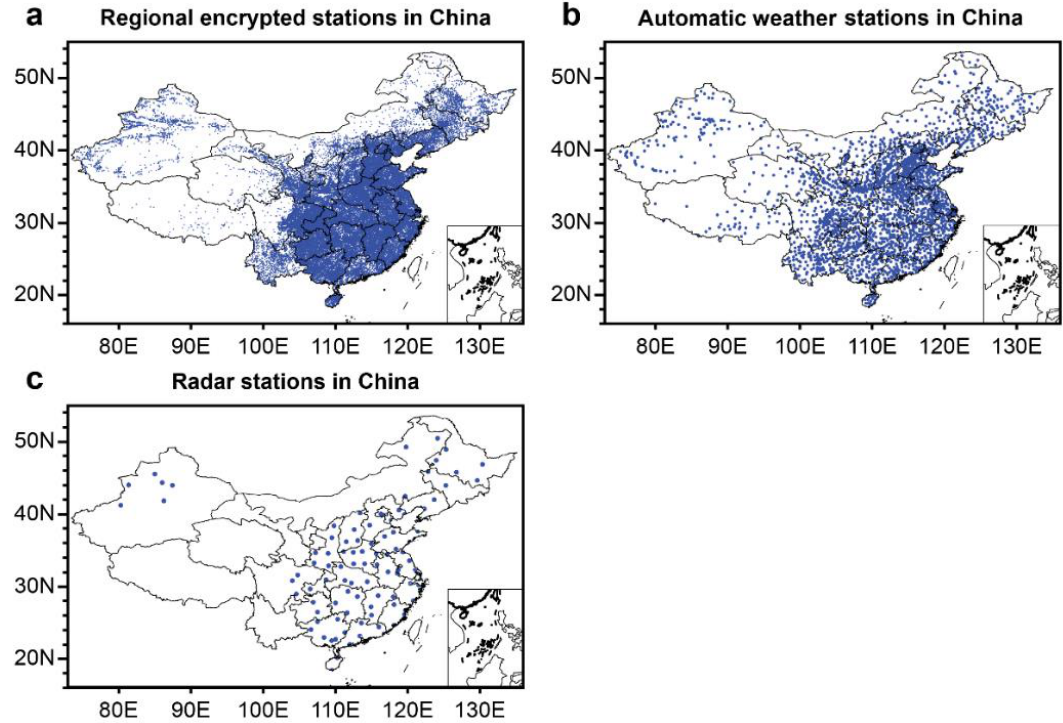
Figure 2. The several important raw input data for the CMADS datasets ( a ) Regional encrypted stations, ( b ) National automatic stations, ( c ) Radar stations.